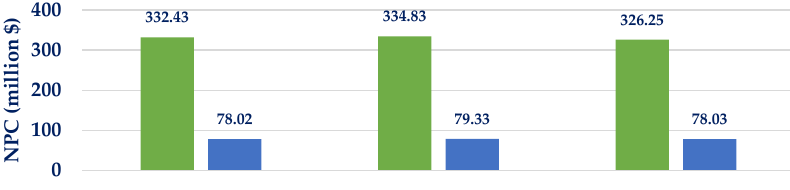
Figure 18. Seasonal peak demand shift of ( a ) electric load; ( b ) thermal load.